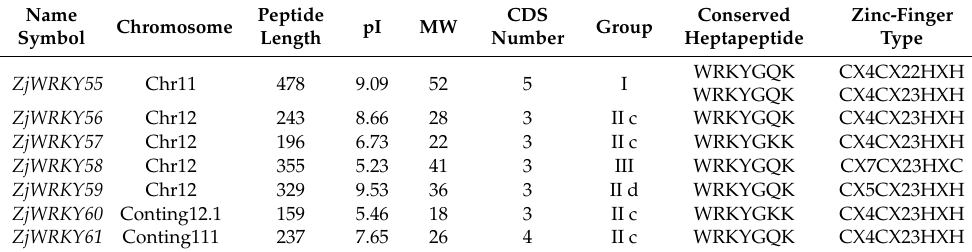
Table 2. Identified WRKY genes in the genome of Ziziphus jujuba ‘Junzao’.